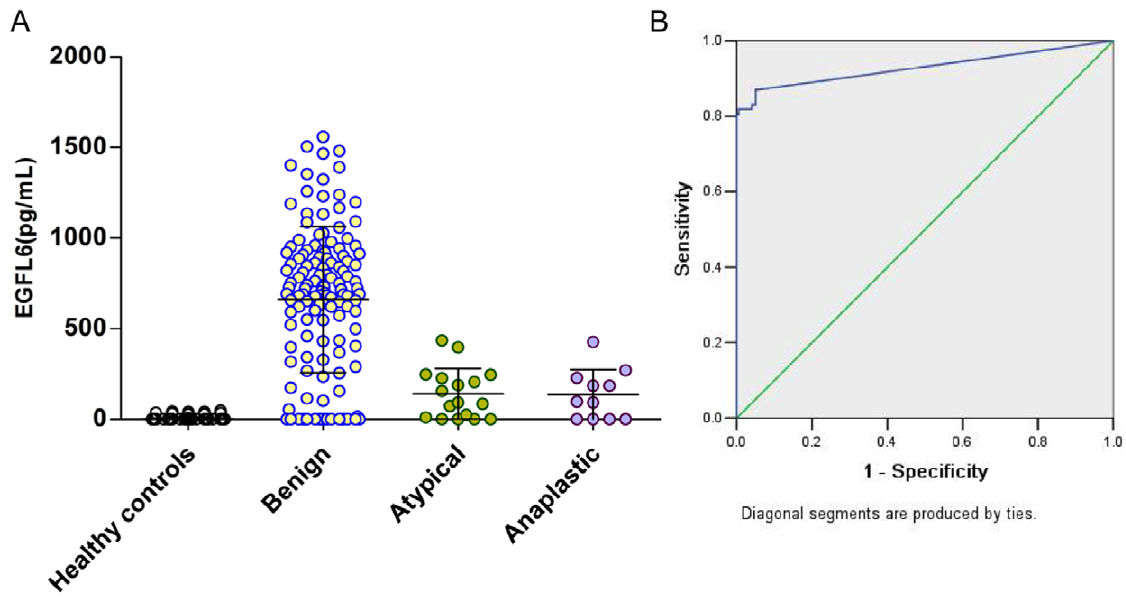
Figure 5. Serum EGFL6 levels in patients with meningiomas. (A) Scatter plot presentation of serum EGFL6 concentrations in patients with meningioma and healthy controls. Black horizontal lines are means. (B) ROC curve for serum EGFL6 levels in meningioma.